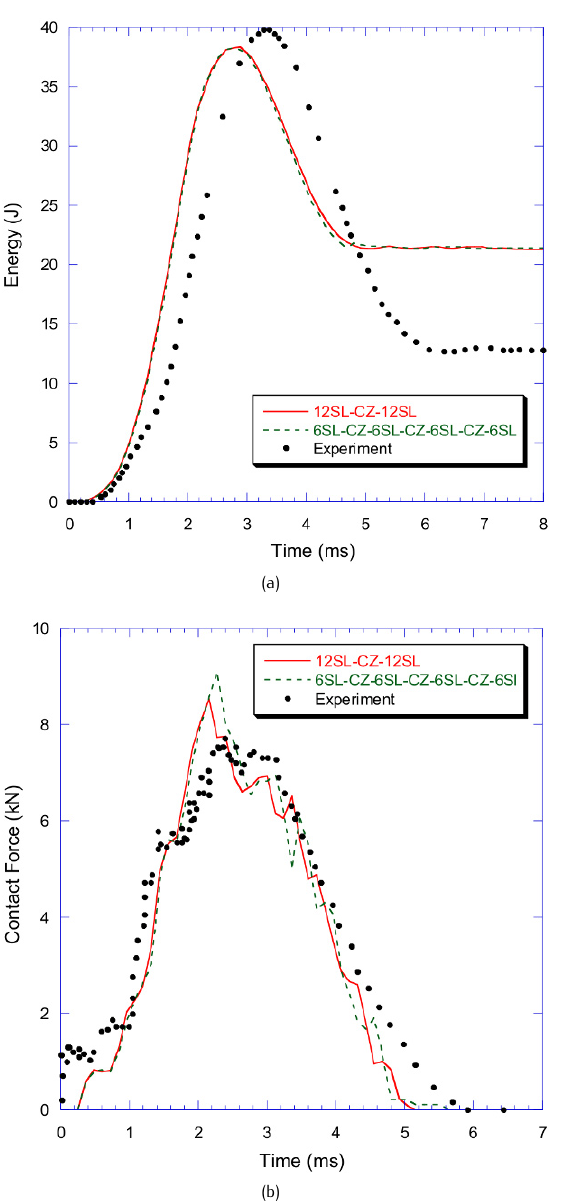
Figure 7. Impact of laminated plate modelled with solid elements (a) internal energy and (b) contact force. Experiment from [5].